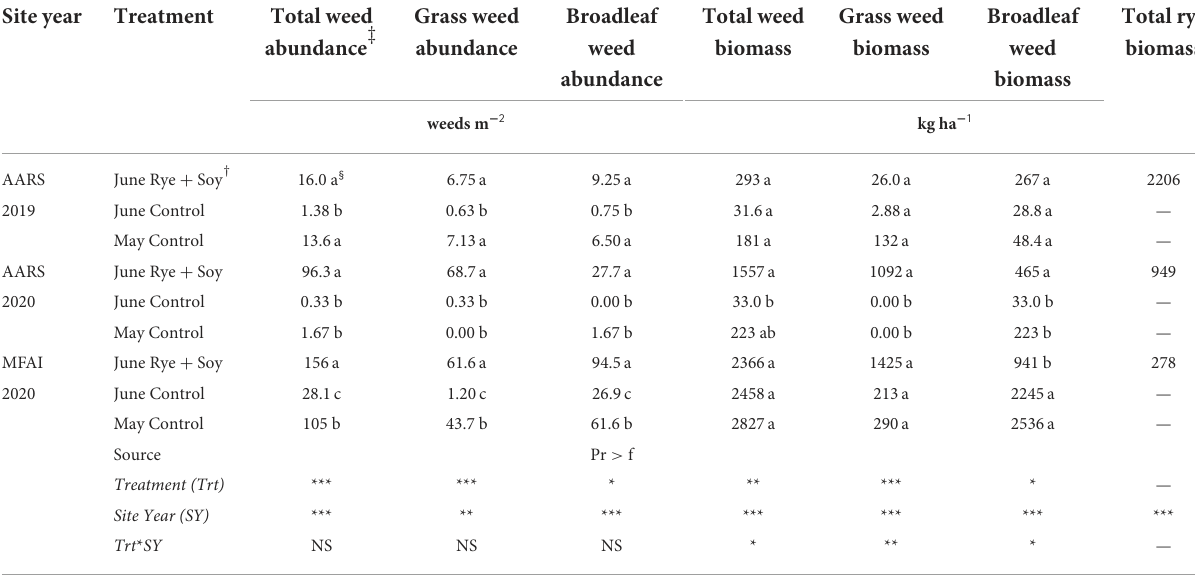
TABLE 2 Analysis of variance and treatment means of biomass (dry matter basis) and abundance of total, broadleaf, and grass weeds located at the Arlington Agricultural Research Station (AARS) in Arlington, WI and the Michael Fields Agricultural Institute (MFAI), East Troy, WI,